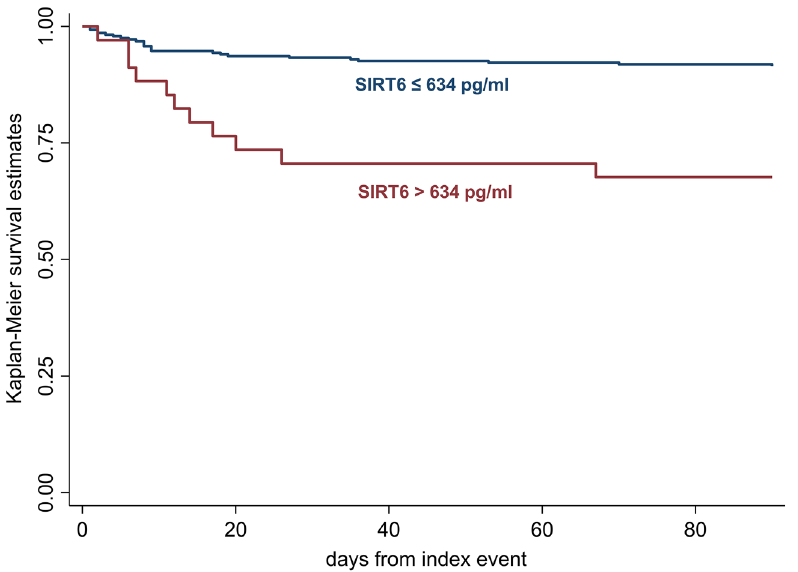
Figure 3. Comparison of overall survival between patients with high and low levels of SIRT6, through Kaplan– Meier curve